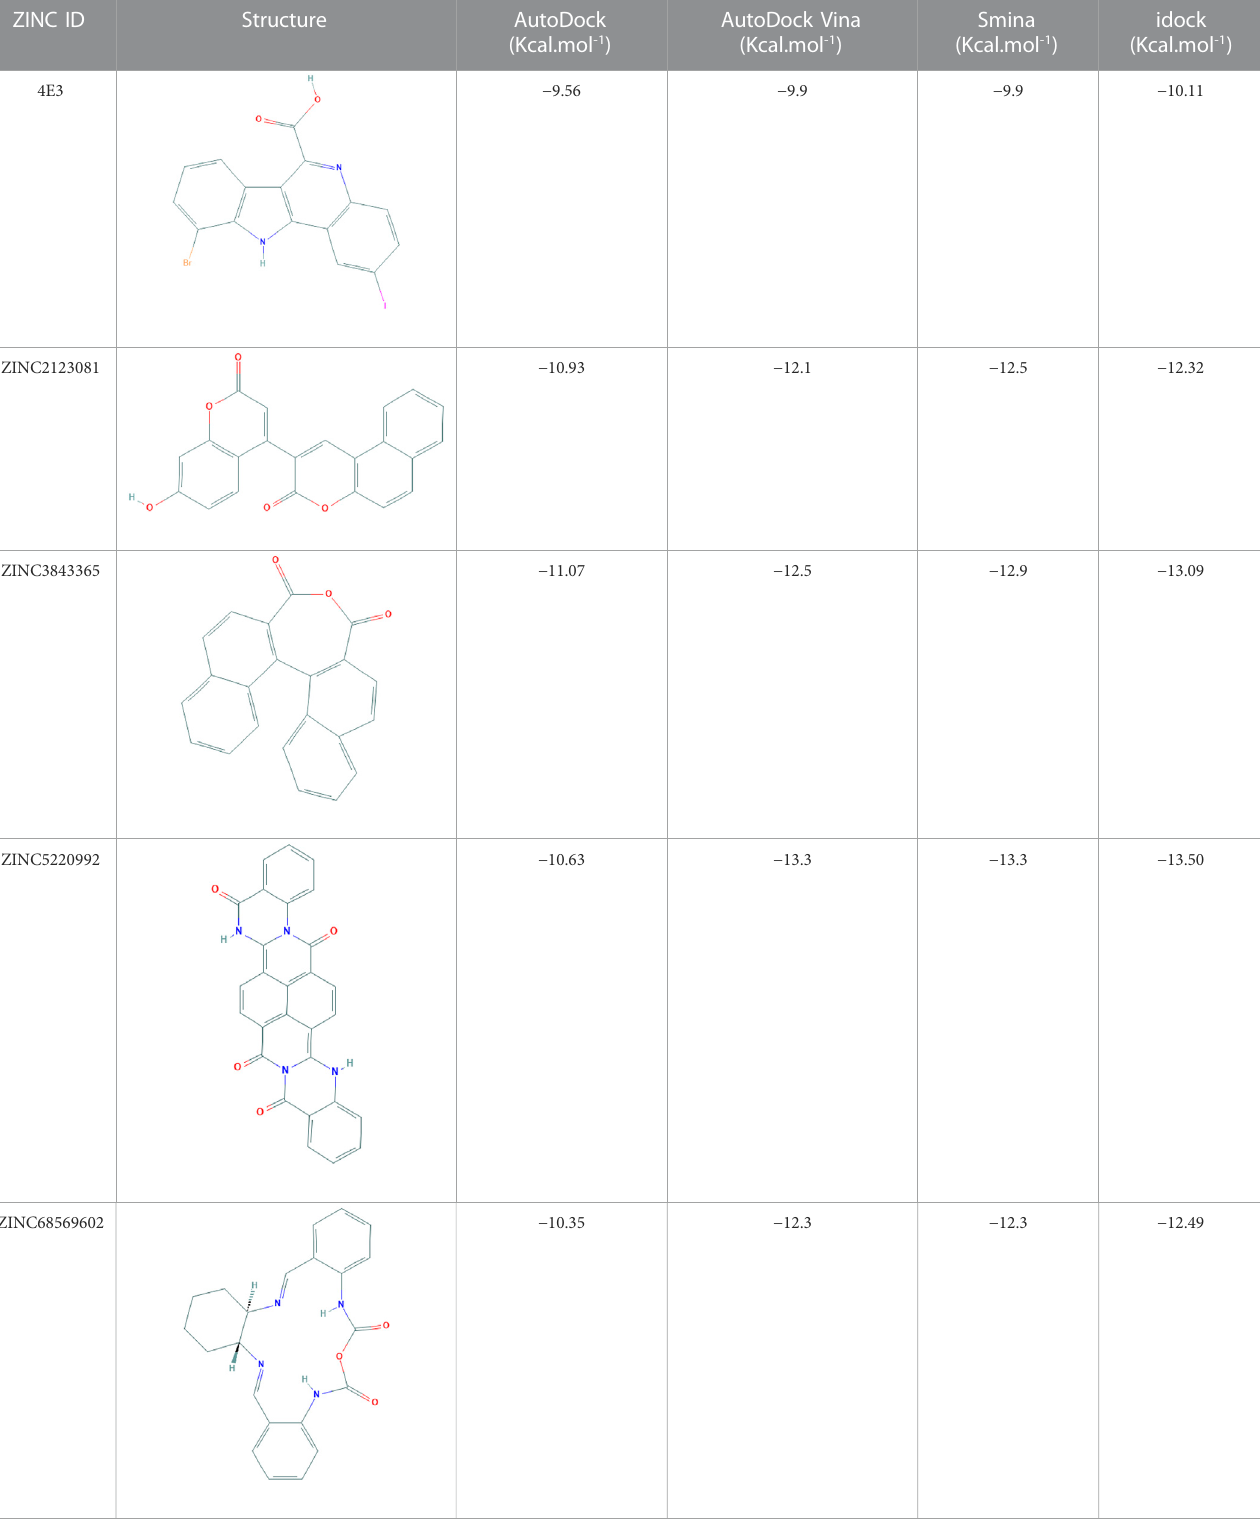
TABLE 1 Details of the four selected compounds with the control compound 4E3. ZINC ID, 2D structure, and binding af fi nity obtained after molecular docking are